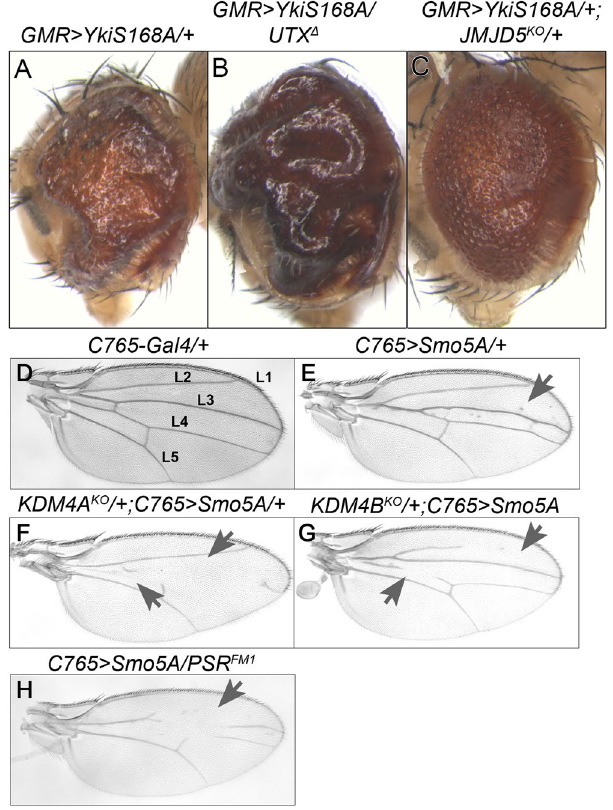
Figure 6. Specific JmjC mutant alleles modify phenotypes caused by disruption of two different signaling pathways. ( A – C ) Adult eyes of the indicated genotypes. Disruption of the Hippo pathway by overexpressing constitutively active Yki S168A , using the eye driver GMR-Gal4 , results in a massively overgrown eye ( A ). Removing one copy of UTX Δ ( B ) enhances, and removing one copy of JMJD5 KO ( C ) suppresses this phenotype. ( D – H ) Adult wings of the indicated genotypes. Disruption of the Hedgehog pathway by overexpressing Smo 5A , using the wing driver C765-Gal4 , results in wing vein phenotypes (arrowheads) ( E ). Removing one copy of either KDM4A KO ( F ) and KDM4B KO ( G ) or PSR FM1 ( H ) enhances the